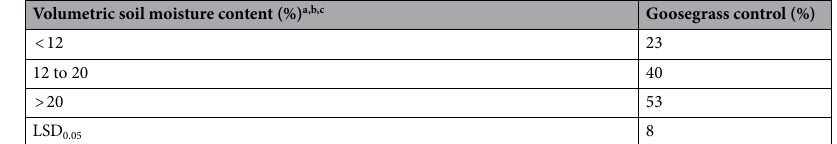
Table 2. Effect of volumetric soil moisture content on goosegrass [ Eleusine indica (L) Gaertn] control 36 days after treatment with postemergence herbicides in a glasshouse experiment conducted Rutgers University (New Brunswick, NJ) in July 2019. a Volumetric soil moisture content measured daily using moisture meter (ML-3 Theta Probe. Delta-T Devices. Cambridge, United Kingdom). b Herbicides included carfentrazone-ethyl + 2,4-D-ester + mecoprop-p + dicamba (Speedzone. PBI Gordon Corporation. Shawnee, KS) at 28 + 857 + 269 + 78 g ha −1 , respectively; topramezone (Pylex. BASF Corporation. Research Triangle Park, NC) at 24 g ha −1 ; fenoxaprop-ethyl (Acclaim Extra. Bayer Crop Science. Cary, NC) at 140 g ha −1 ; foramsulfuron (Revolver. Bayer Crop Science. Cary, NC) at 44 g ha −1 ; and thiencarbazone- methyl + foramsulfuron + halosulfuron-methyl (Tribute Total. Bayer Crop Science. Cary, NC) at 22 + 45 + 67 g ha −1 , respectively. Adjuvants were included per label recommendations. c Herbicides were applied in an enclosed spray chamber (Generation III track sprayer. DeVries Manufacturing, Hollandale, MN) using a water carrier at 215 L ha −1 through an 8004 EVS nozzle (TeeJet, Wheaton, IL). Application made 22 July